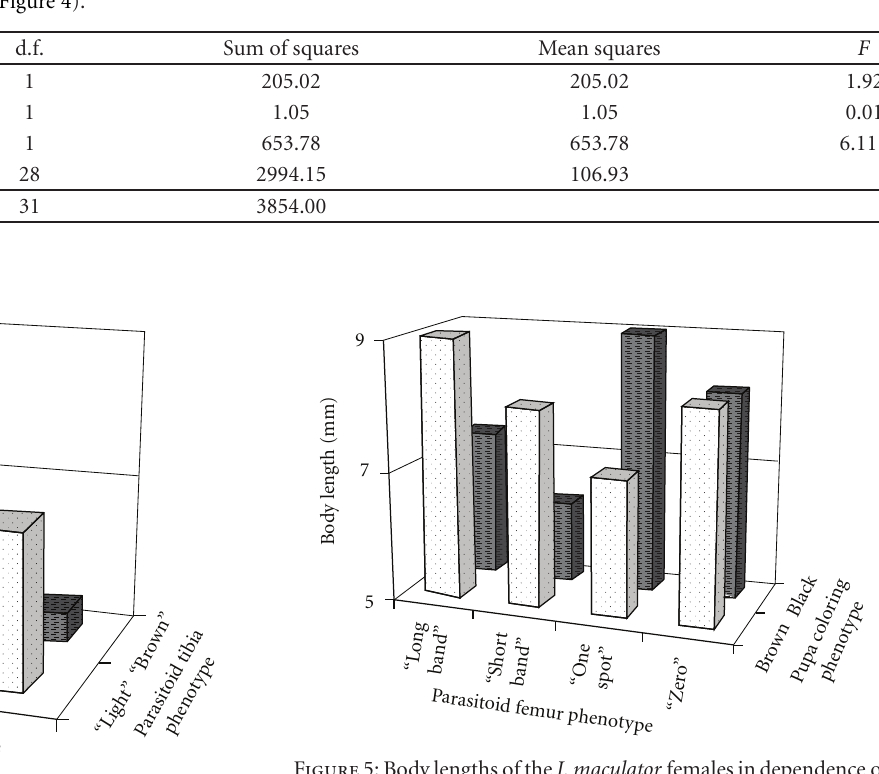
Figure 5: Body lengths of the I. maculator femalesin dependence on their phenotypes and phenotypes of their host insect pupae (results of two-way ANOVA in Table